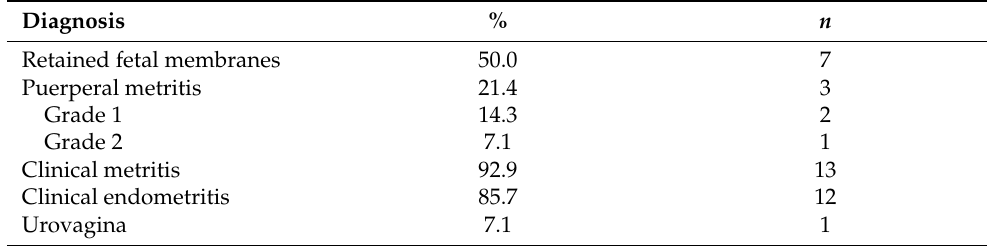
Table 3. Distribution of C. perfringens - positive diseased cows with respect to the disease patterns shown during puerperium. Numbers add up to more than 14, since some cows had more than one diagnosis. Diagnosis % n Retained fetal membranes 50.0